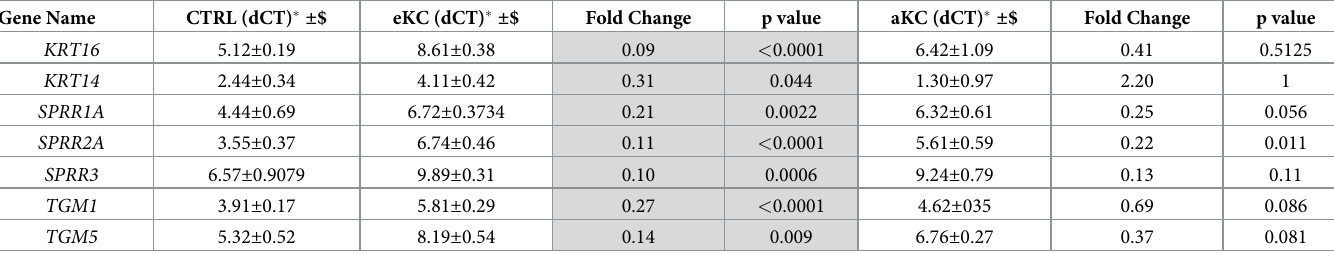
Table 2. Genes with significant differential transcript expression in early and advanced